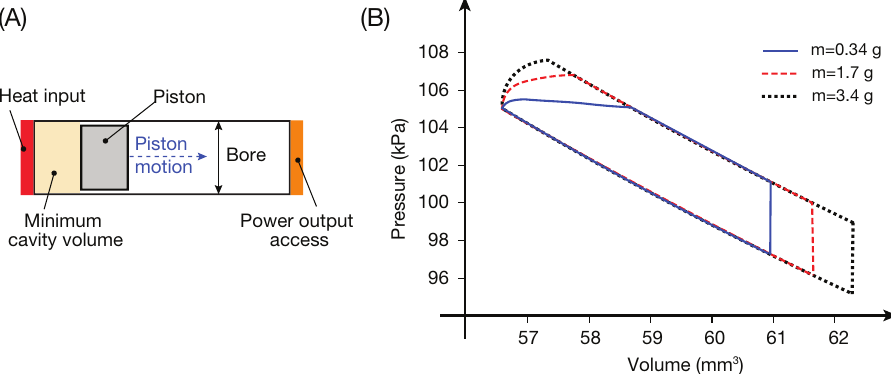
Figure 6. An overview of millimeter scale FPE: ( A ) schematic sketch of the FPE with heat input and power output access ports shown; and ( B ) effect of different piston mass “m” on expander P-V curve with constant load and heat inputs